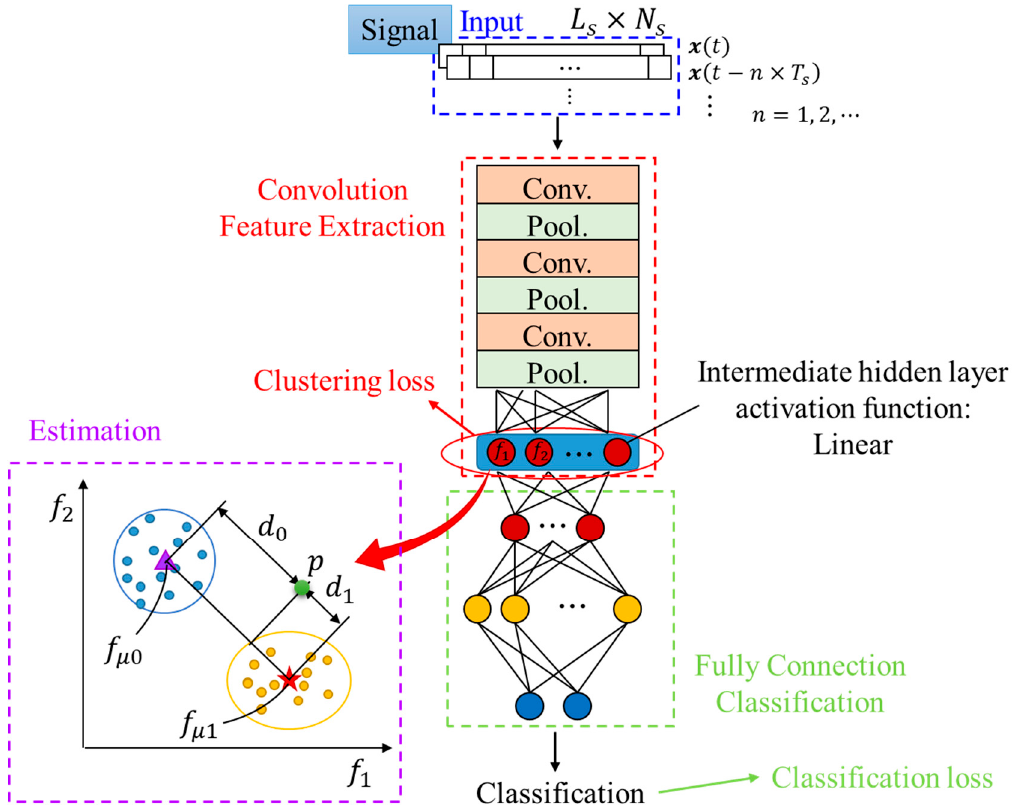
Figure 3. The whole 1-D CNN based on the clustering loss estimation model.